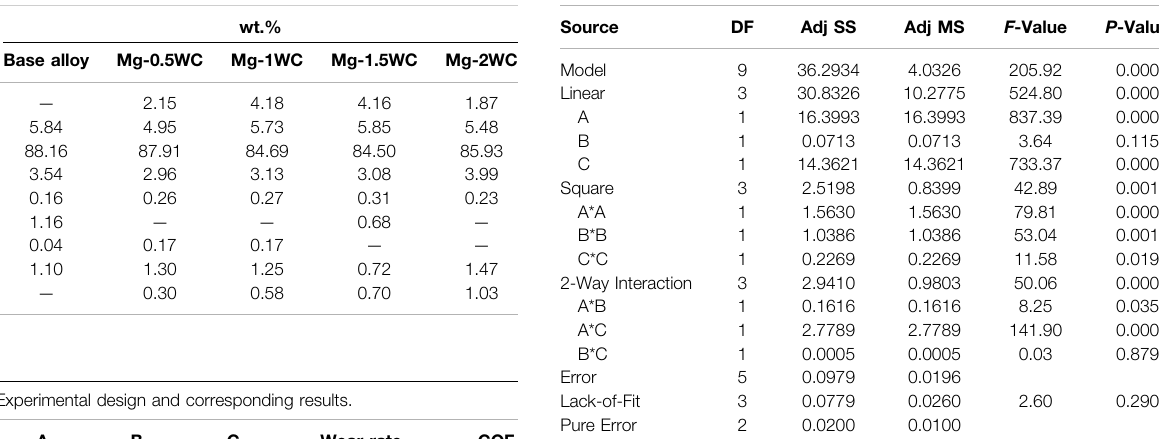
TABLE 4 | ANOVA table of wear